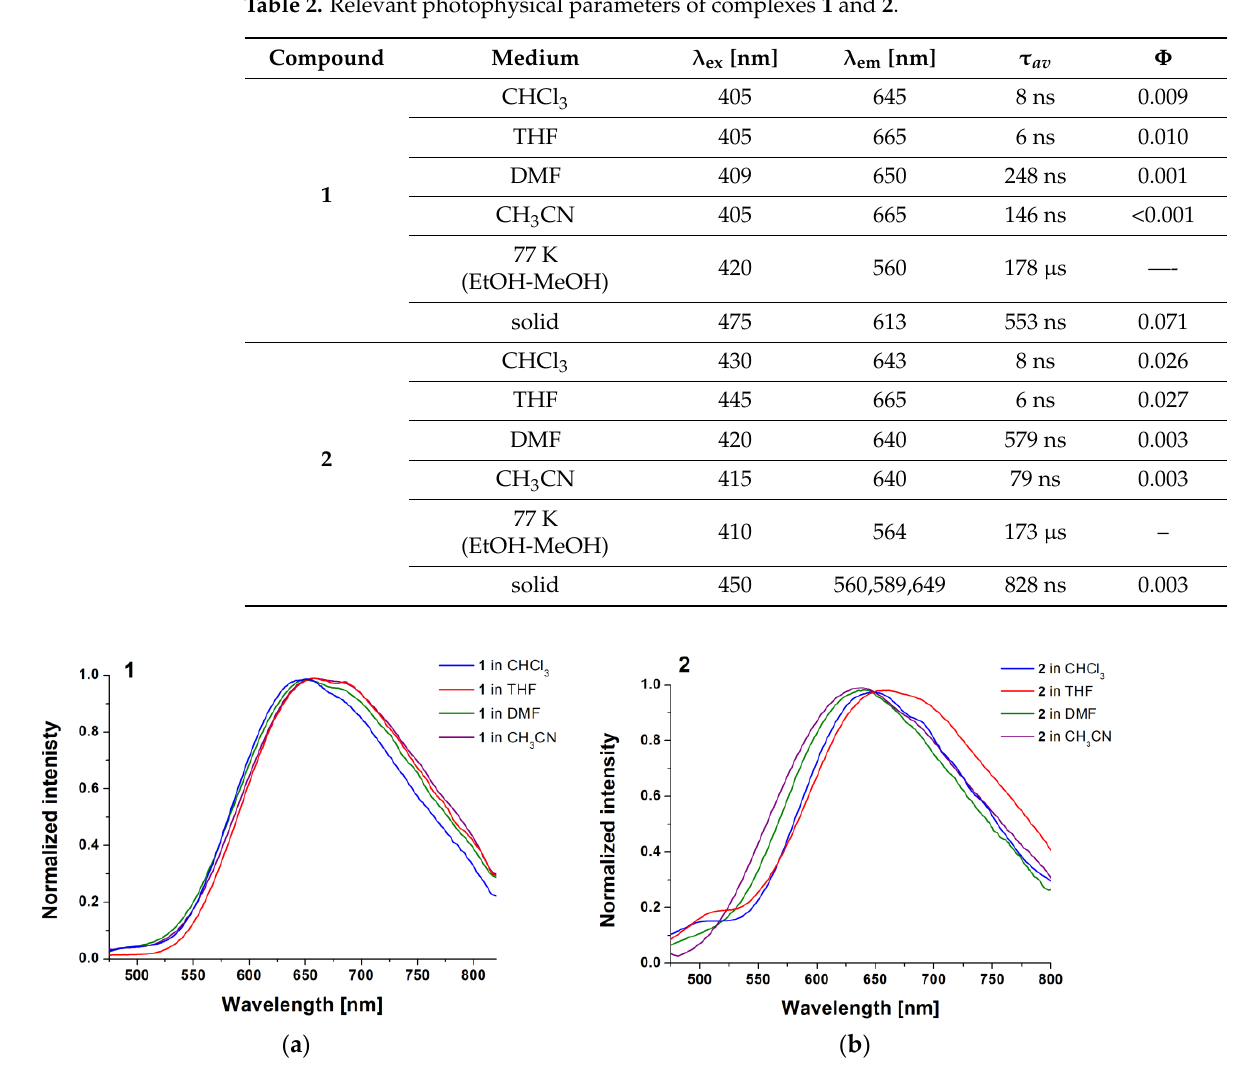
Table 2. Relevant photophysical parameters of complexes 1 and 2 .